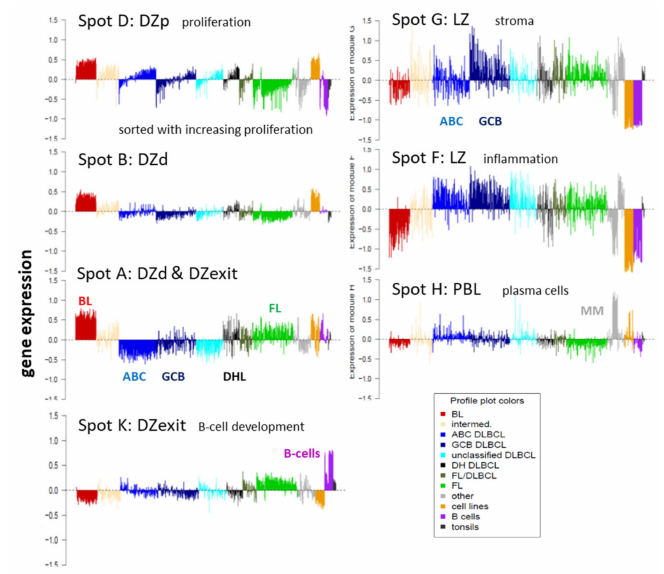
Figure A3. Gene expression spot profiles across the lymphoma subtypes and their association with steps of the GC reaction (see also Figure 2). Tumors are ranked with increasing cell cycle activity for each subtype using the signature of [85]. DLBCL tumors show high variability with the cell cycle while BL do not. Spot G (and F) reflects anticorrelation with cell cycle activity. Notably, spot activation follows the GC trajectory shown in Figure 2d. Spots D, B and A are upregulated in BL where D and A also activate in DLBCL and FL, respectively; spot K in FL, spot G in GCB-DLBCL, spot F in DLBCL and FL and spot H in MM (multiple myelomas) and ABC-DLBCL.